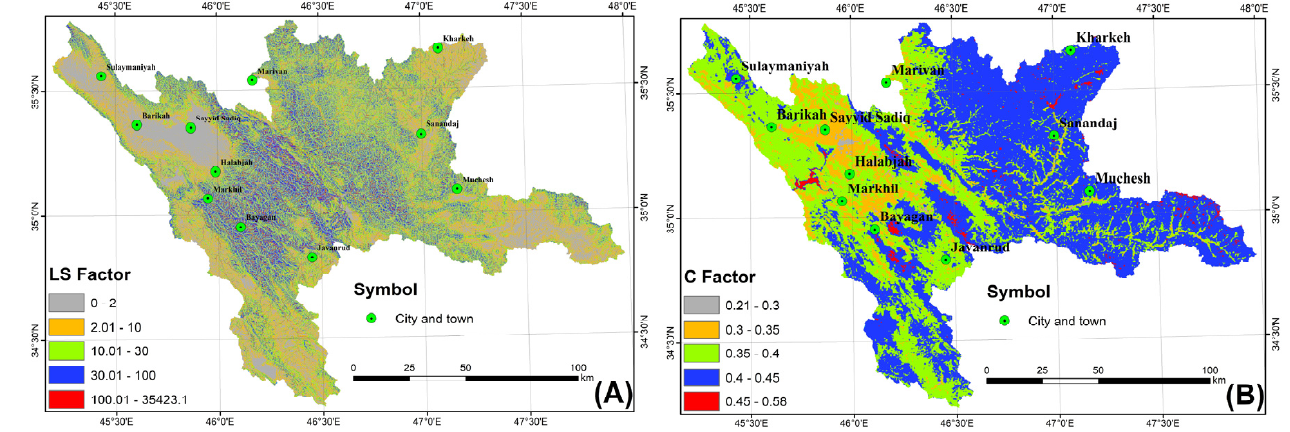
Figure 6. The distribution of the ( A ) LS factors and ( B ) C factors maps within the DLB for the period until 2 May 2008.